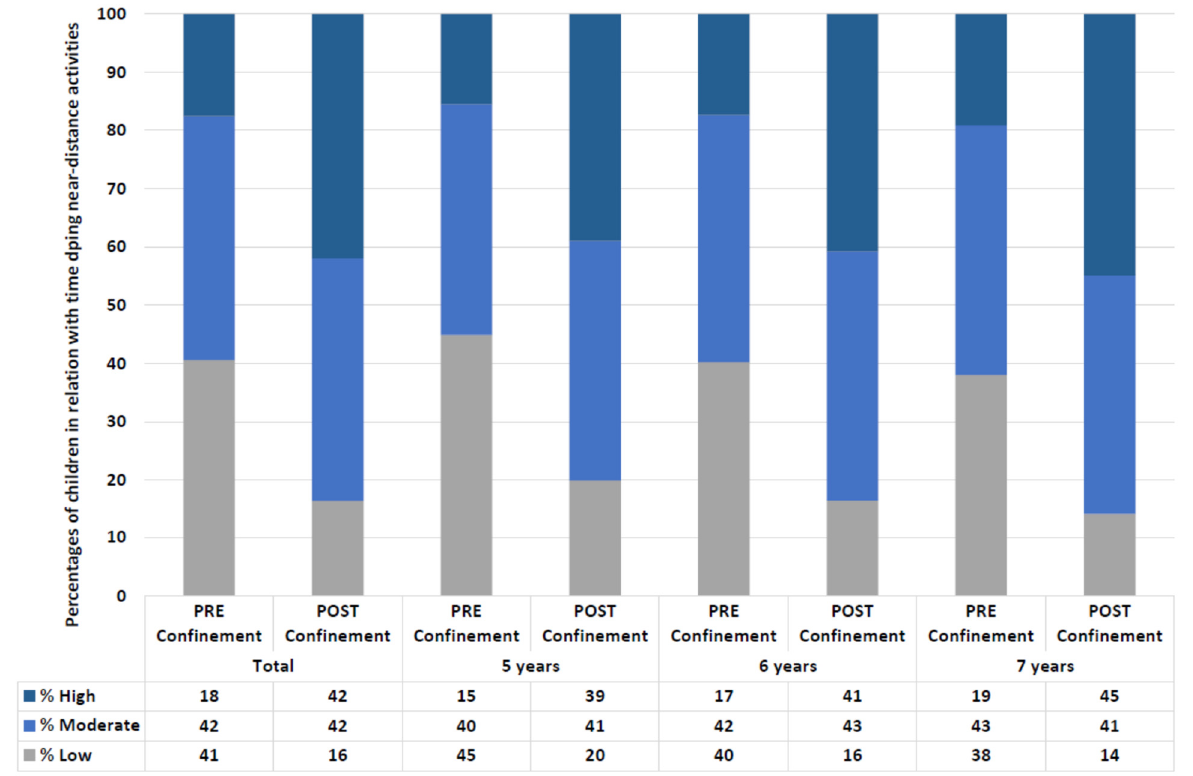
Figure 4. Classification of children depending on the time they spent doing near distance activities in all the sample and by ages (Low: <2 h a day; Moderate: 2–3 h a day; High: >3 h a day).